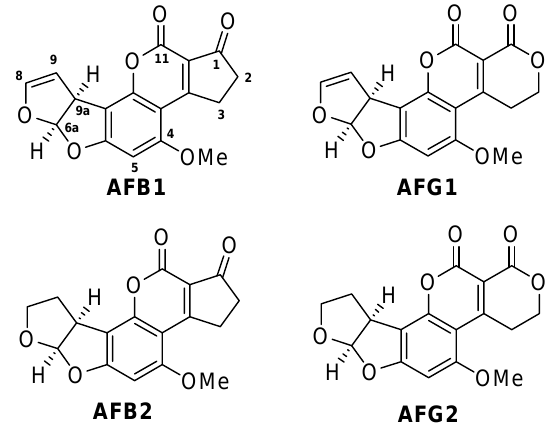
Figure 1. Structures of the most important aflatoxins B1, B2, G1,